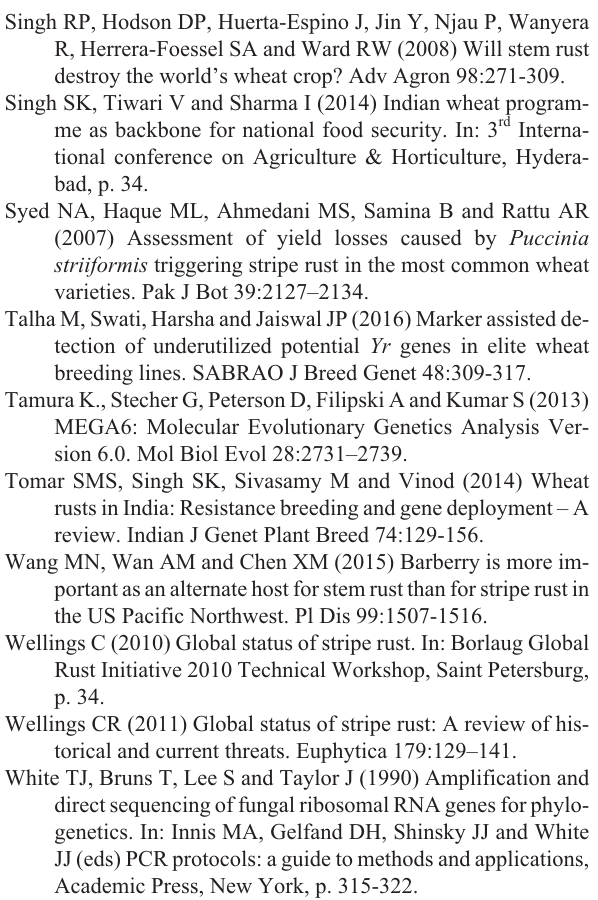
Figure S1 - Agarose gel showing amplified products. Figure S2 - Multiple sequence alignment of internal tran- scribed spacer 1. Figure S3 - Multiple sequence alignment of internal tran- scribed spacer 2. Table S1 - Details of genes and primers. Table S2 - NCBI sequences of ITS, (cid:2) -tubulin, and ketopantoate